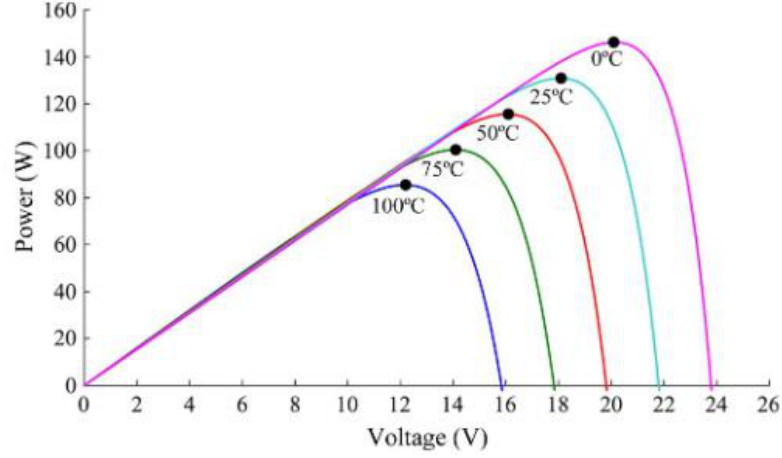
Figure 7. Power–voltage curve of a PV module at different temperatures